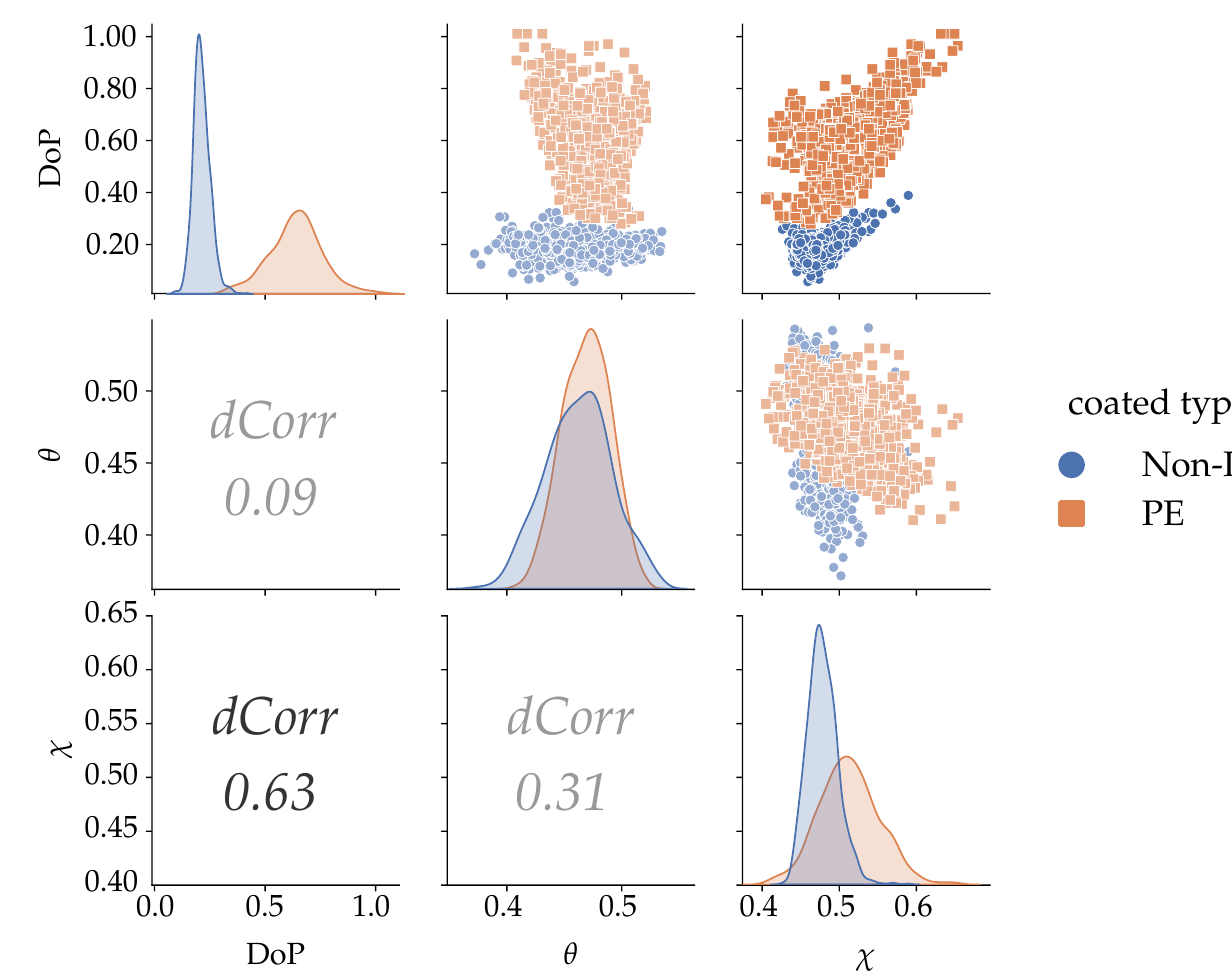
Figure 7. Scatter matrix displaying the relation between features degree of polarization (DoP), ϕ , and χ . The dCorr value represents the distance correlation between the features. All the features in the dataset are normalized and only 20% of the dataset is shown to aid in the